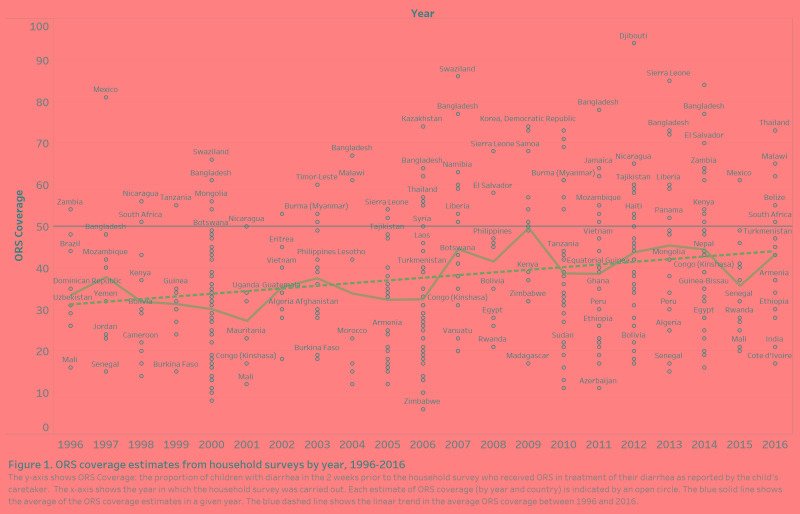
Oral rehydration salt (ORS) coverage from household surveys by year, 1996-2016. The axis shows ORS coverage: the proportions of children that had diarrhea in the two-weeks prior to the household survey who received ORS in treatment of their diarrhea as reported by the child’s caretaker. The x-axis shows the year in which the household survey was carried out. Each estimate of ORS coverage is (by year and country) is indicated by an open circle. The blue solid line the average ORS coverage estimates for the given year. The blue dashed line shows the linear trend in the average ORS coverage between 1996 and 2016.